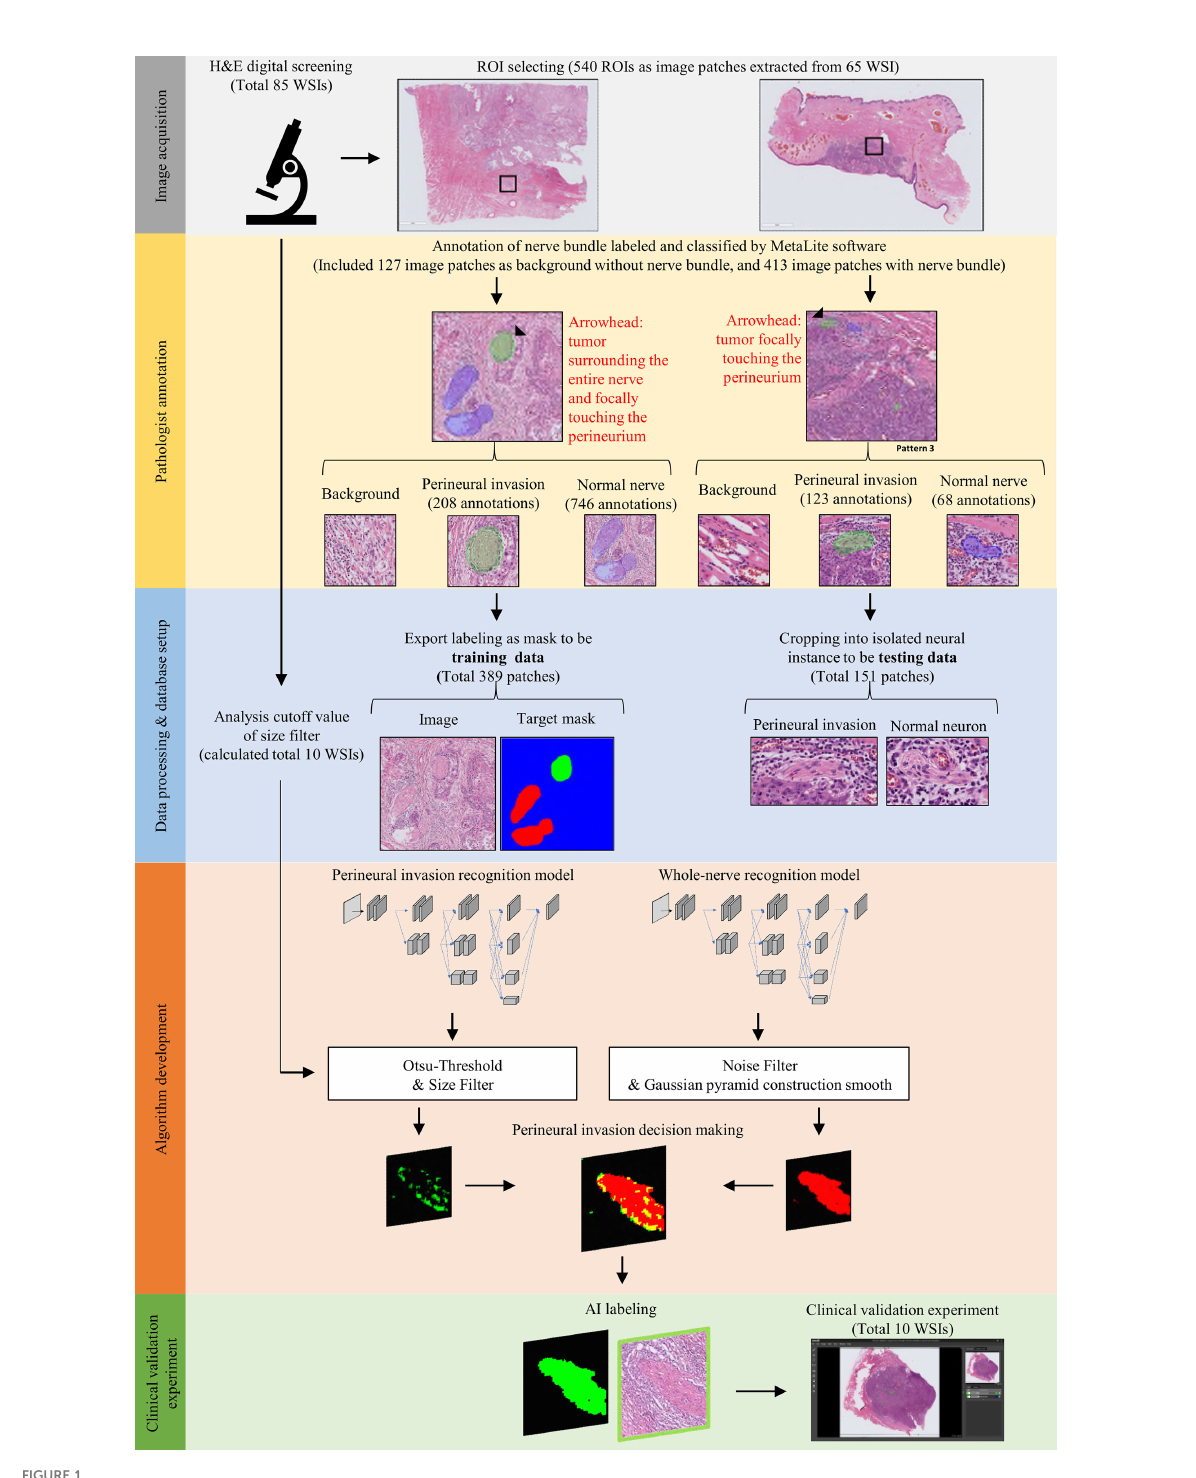
FIGURE 1 Work fl ow used for image acquisition and ground truth annotation. Image acquisition was undertaken by selecting and extracting ROI patches (black rectangle) from whole slide images. Subsequently, trained technicians supervised by an expert pathologist annotated areas of perineural invasion (marked in green) and normal nerve structures (marked in blue). Finally, labeled patches were processed to binary training data sets with appropriate masks; alternatively, they were used for building a testing data set for the recognition of nerve